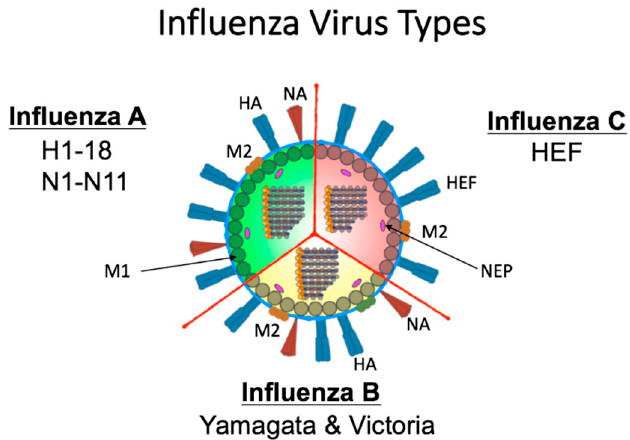
Figure 2. Schematic of Influenza A, B, and C virus structure. Influenza A is defined by its surface proteins hemagglutinin (HA) and neuraminidase (NA) of which there are 18 HA and 11 NA. Influenza B viruses are categorized into two lineages (B/Yamagata and B/Victoria). The surface of both A and B viruses contains HA, NA, and the M2 proteins. Internally, A and B viruses both have eight genomic segments. Influenza C viruses have only one external spike protein (HEF) which functions both in viral entry and egress and an ion channel M2 protein. Type C viruses have 7 internal genomic segments. M1 protein line the envelope internally adjacent nuclear export protein (NEP) proteins for type A, B, and C viruses. The genomic segments are encapsidated by the NP protein and form the ribonucleocapsid with the polymerase proteins Polymerase acidic (PA), Polymerase basic 1 (PB1), and Polymerase basic 2 (PB2).